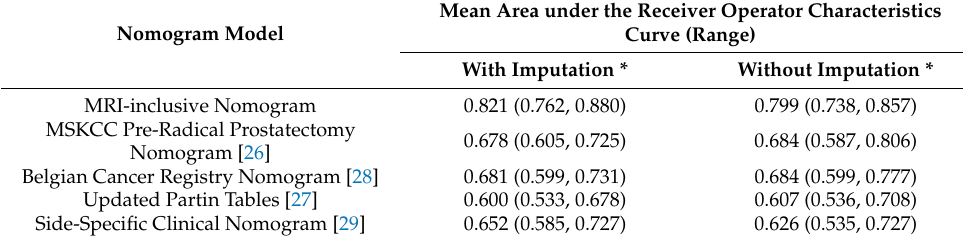
Table 4. Validation of the diagnostic performance of the MRI-inclusive and benchmark nomograms by using data from six institutions as training set and data from the others as validation set. This process was repeated on all 210 possible permutations, both with and without imputation of missing